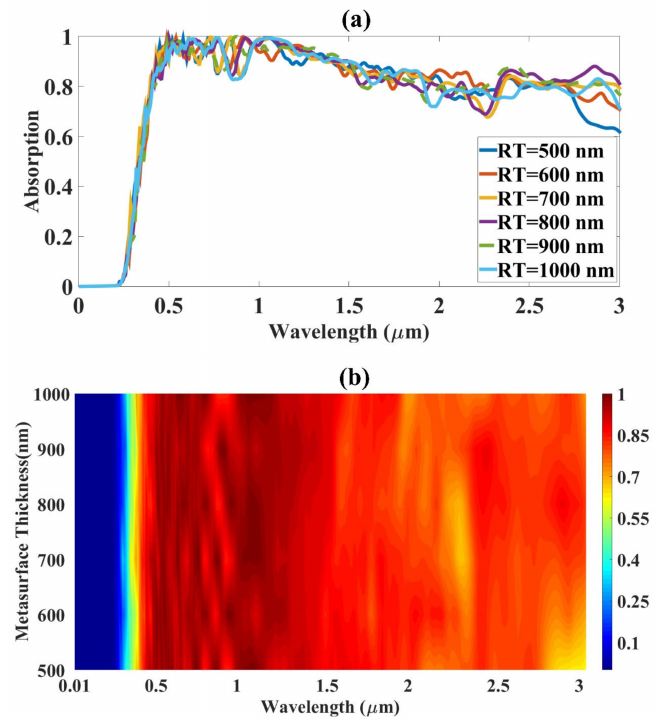
Figure 3. Absorption response for variation in RT (resonator thickness). Variation is carried out 500 to 1000 nm with a separation of 100 nm. The results are presented in the form of ( a ) line, ( b ) color plots for 0 to 3000 nm.